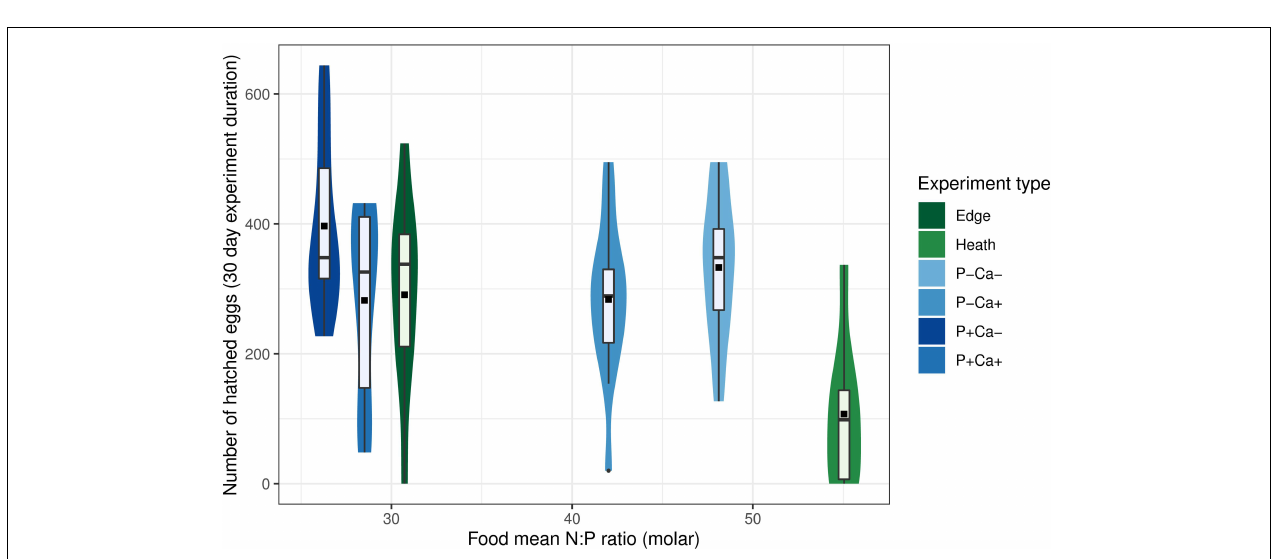
FIGURE 5 | Comparison of reproductive potential of female Gryllus campestris with mean plant tissue N:P ratio under two feeding experiments. Blues: current experiment (by experimental treatment). Greens: experiment performed with plant material collected from Strabrechtse Heide heathland under contrasting nutrient availability (Vogels et al., 2013). Edge: edge between Calluna vulgaris dominated heathland and extensive agricultural field. Heath: Calluna vulgaris dominated dry heathland on mineral poor aeolian sand deposits. For comparability with the Strabrechtse Heide experiment, number of hatched eggs was taken at 30 days experimental duration in the current experiment. Violins indicate data distribution. Boxes indicate 25, 50, and 75% quantiles, whiskers indicate all data within 1.5*interquantile range, dots represent outliers, squares indicate group